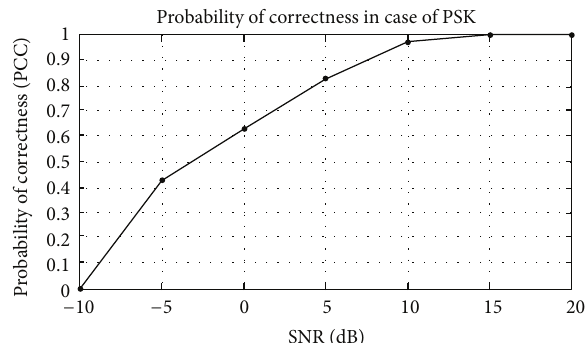
Figure 11: Probability of correctness (PCC) versus SNR for fixed number of iterations in PSK4 example.